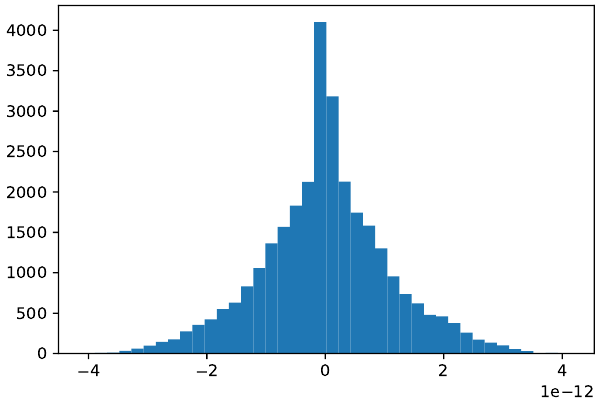
Fig. 109.— Histogram of the relative difference from the average of the triangle areas corresponding to each time step